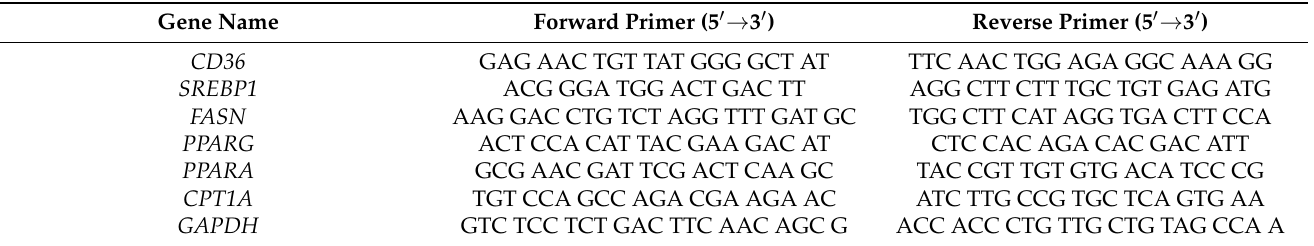
Table 3. Primer sequences for